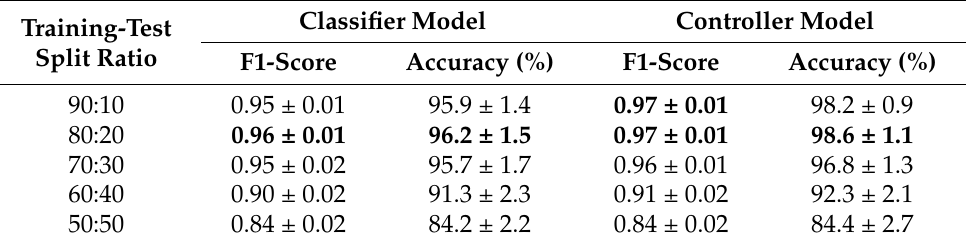
Table 7. The classification results of the proposed models with different input image sizes (mean ±